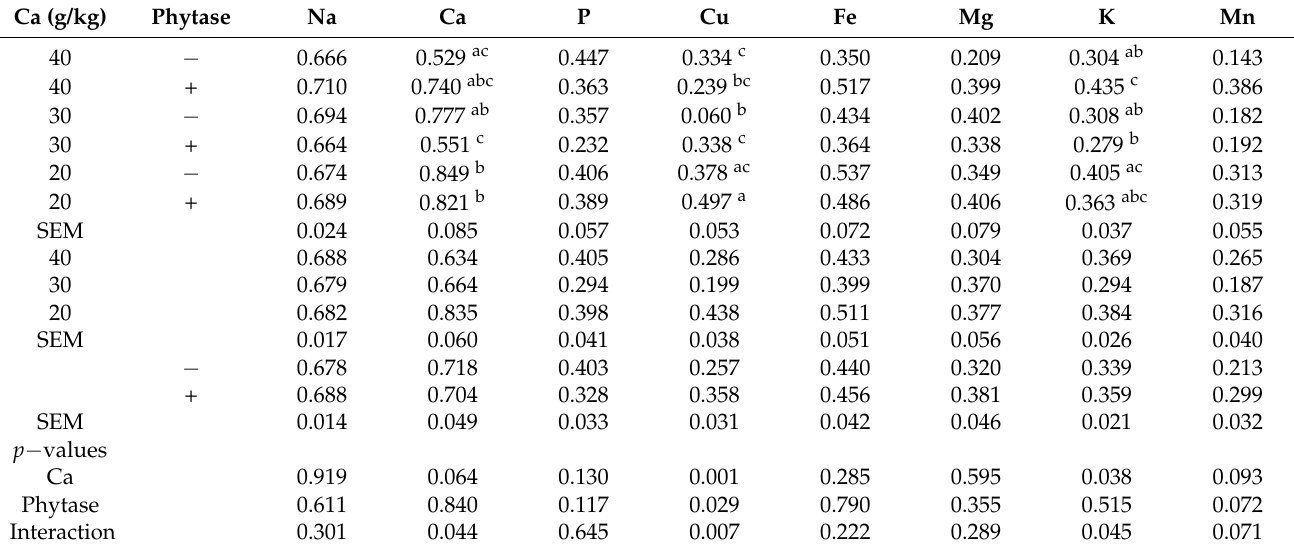
Table 7. The impact of different dietary Ca levels, phytase, and limestone consumption on measurements of macro and micro mineral